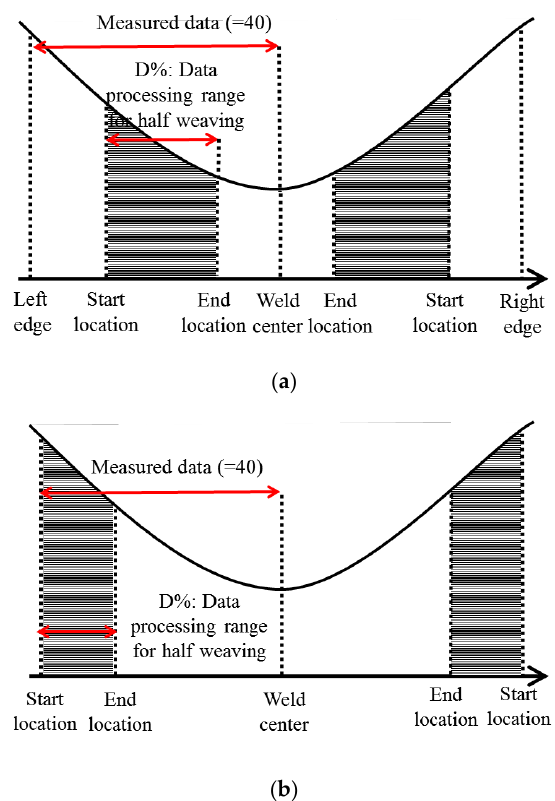
Figure 13. Selection of the signal section for weld seam tracking: ( a ) Root pass welding, ( b ) fill pass welding.